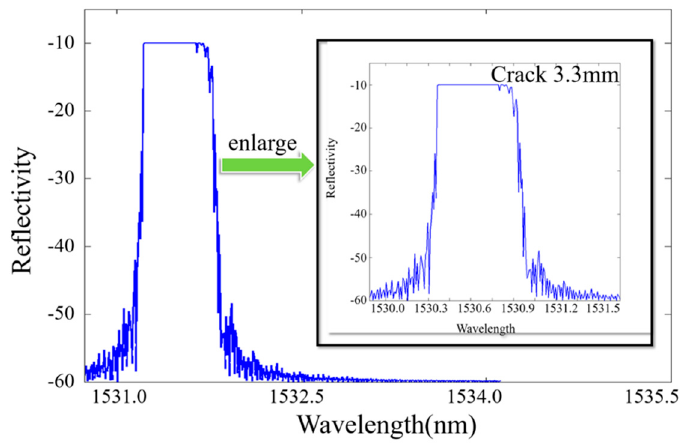
Figure 15. The simulated reflection intensity of a crack with a length of 3.3 mm.